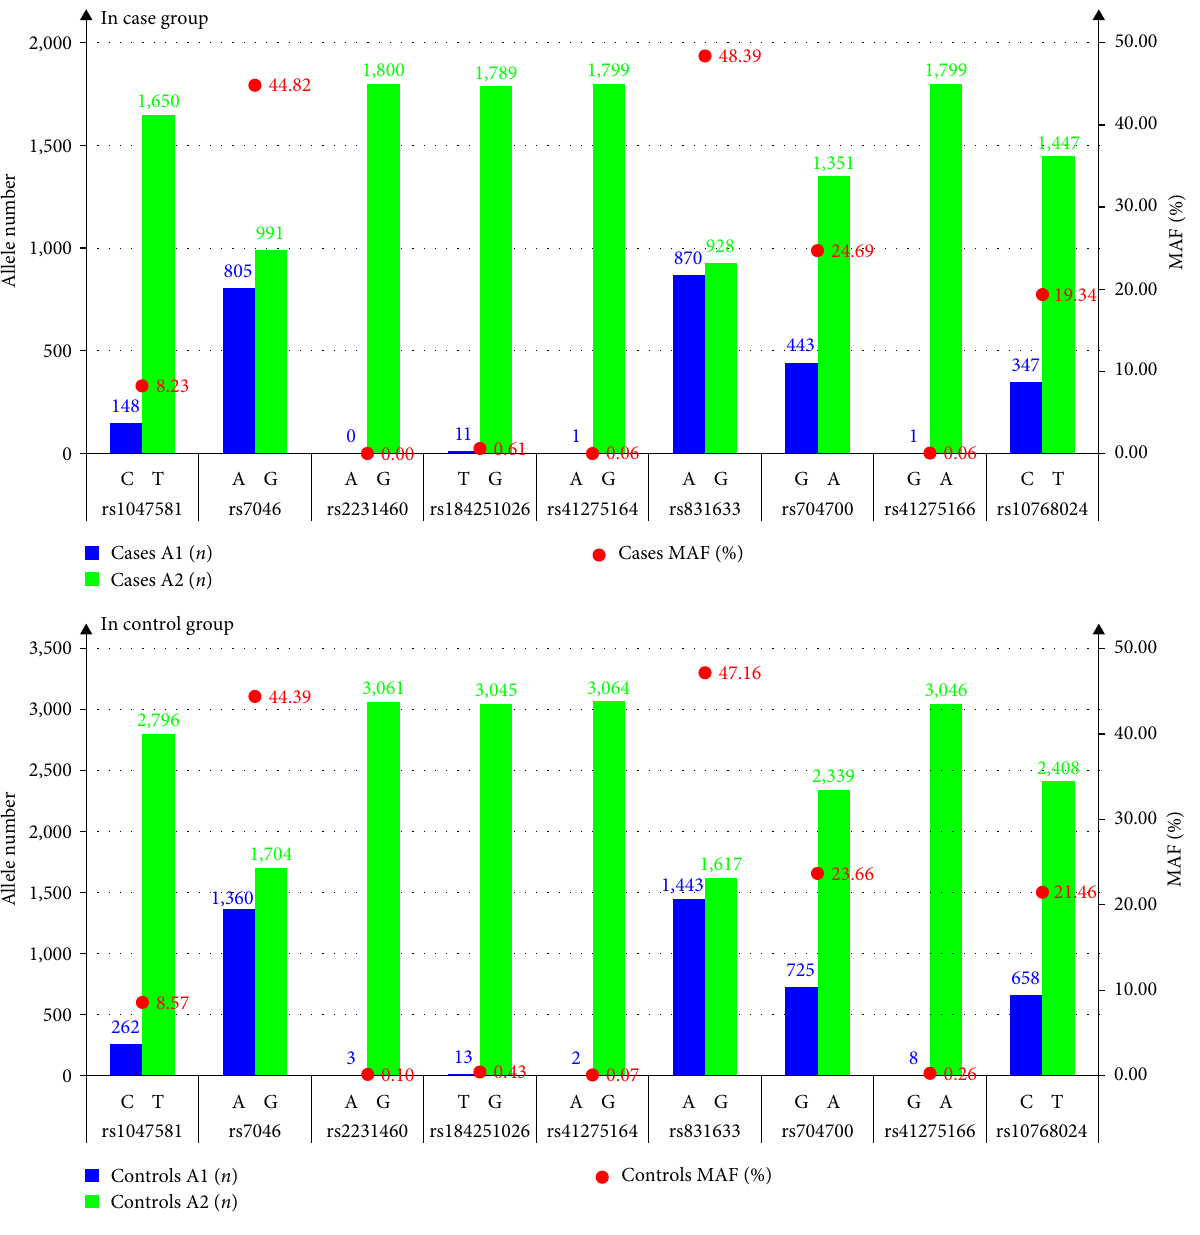
F IGURE 1: Composite graph of allele number histogram with MAF scatter plot. Note: In the label on the horizontal axis, the lower row is SNP, and the two alleles above are its minor allele (A1) and major allele (A2) in order; MAF, minor allele frequency. The histogram shows the number of alleles, and the red scatter shows the size of MAF. Among the nine SNPs of CD59 gene, the rates of allele mutation at